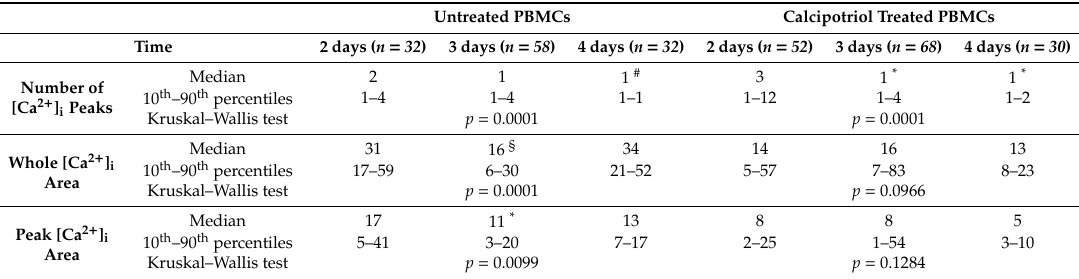
Table 1. E ff ects of time and calcipotriol on the intracellular calcium [Ca 2 + ] i of PBMCs. Untreated and 100 nM calcipotriol-treated PBMCs were studied after 2, 3, and 4days of culture. Data are from four independent experiments, and the total number of analyzed single cells is reported in brackets.